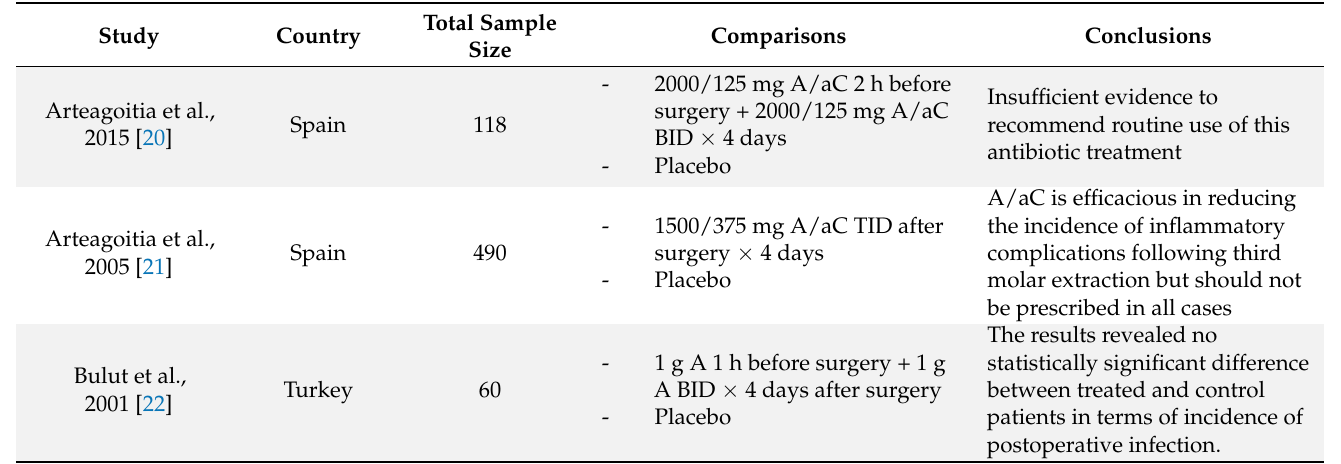
Table 2. Characteristics of included